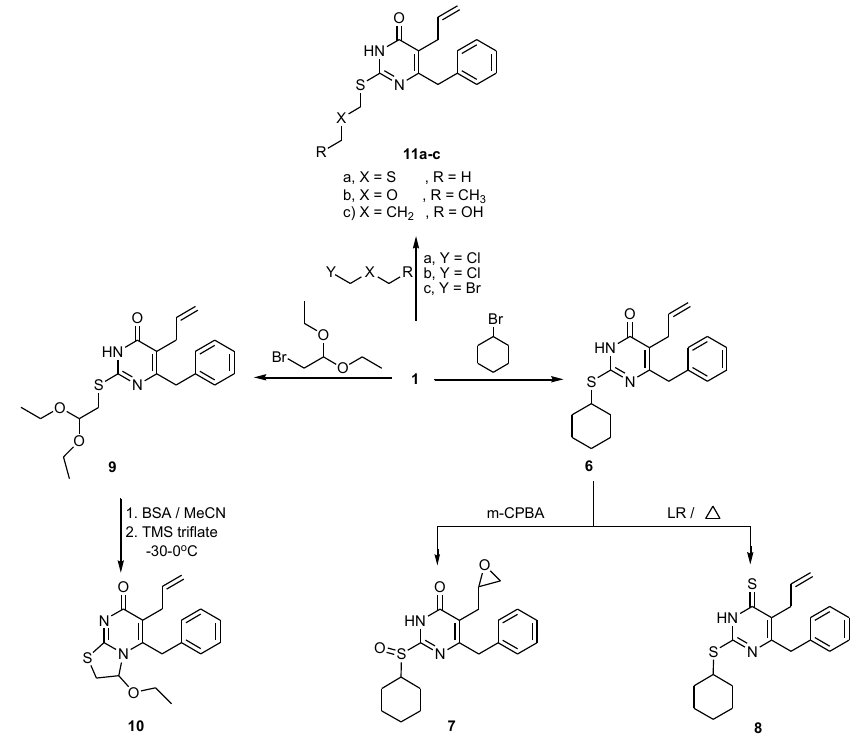
Table 1. Cytotoxicity and anti-HIV-1 activity of newly synthesized compounds in MT-4